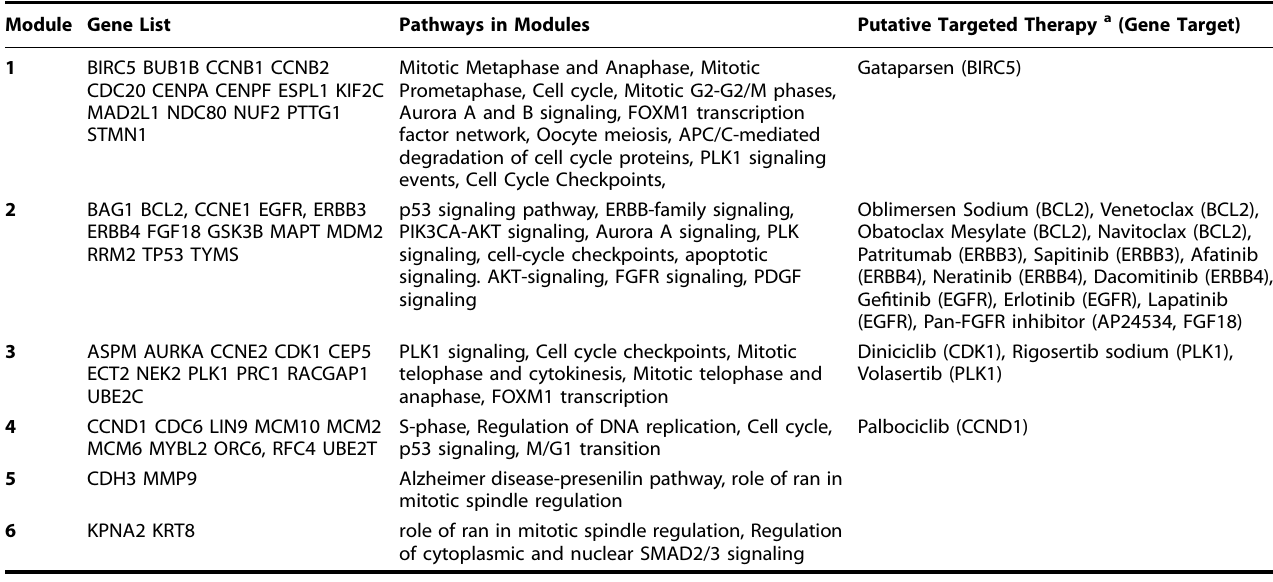
Table 4 Summary of pathway modules comprising the 95-gene residual risk signature Module Gene